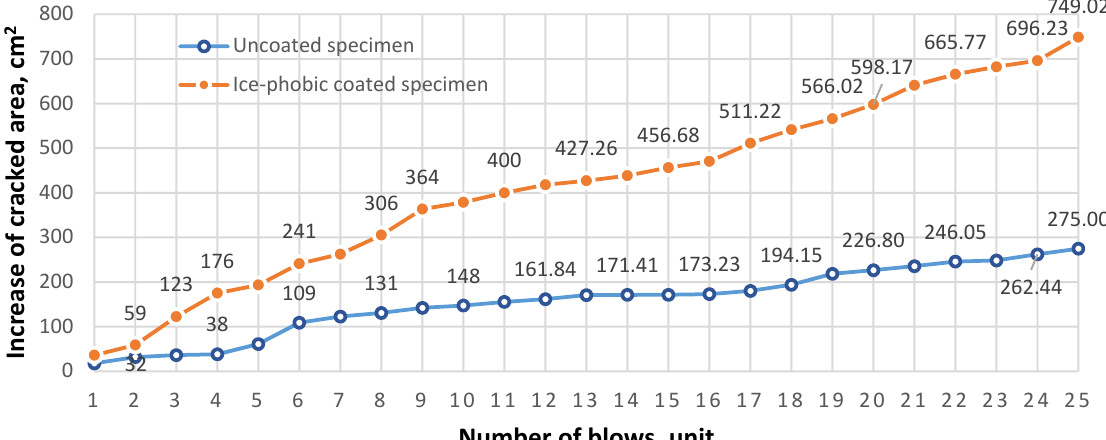
Figure 7. Increase in cracking area as a function of the number of blows.